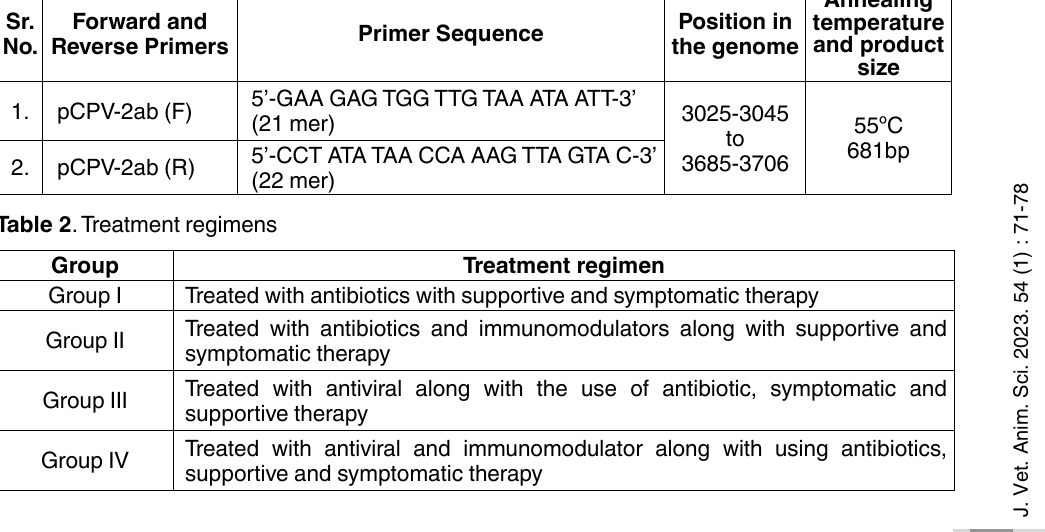
table 1 . Primer sequence used for the amplification of VP1/VP2 gene of CPV sr. No.